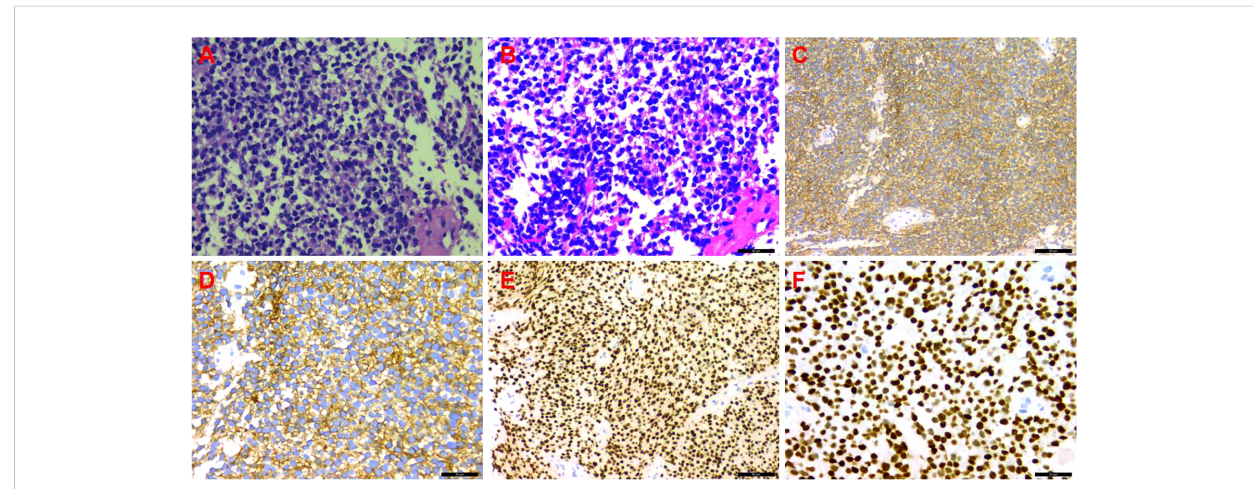
FIGURE 3 Immunohistochemistry. (A) Hematoxylin and eosin (HE) staining (×200); (B) HE staining (×400); (C) CD99 (++++) (×200); (D) CD99 (++++) (×400); (E) NKX2.2 (++++) (×200); (F) NKX2.2 (++++)